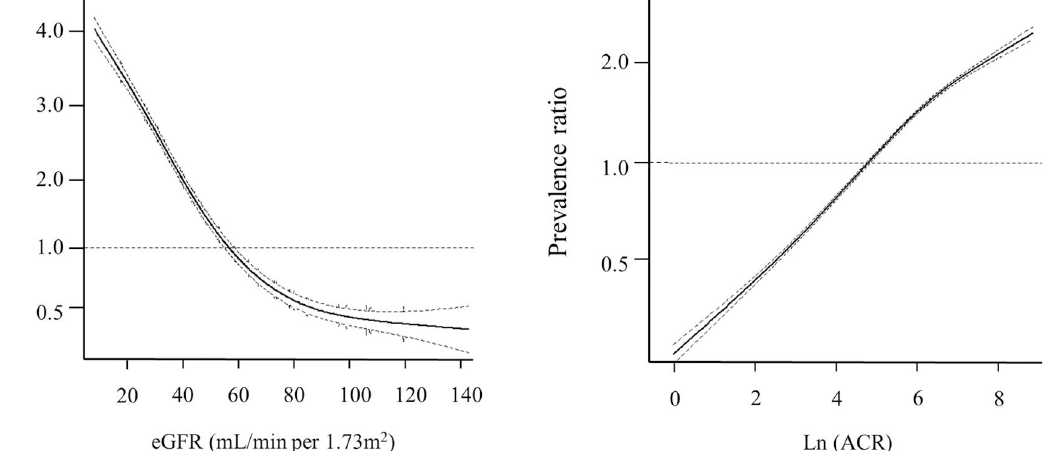
Fig 2. The risk of anemia in relation to the ACR and eGFR. By using generalized additive models, the risk (solid line) and 95% confidence intervals (dashed line) of anemia in relation to the (A) ACR and (B) eGFR is estimated. Abbreviations : ACR, albumin-to-creatinine ratio; eGFR, estimated glomerular filtration rate.